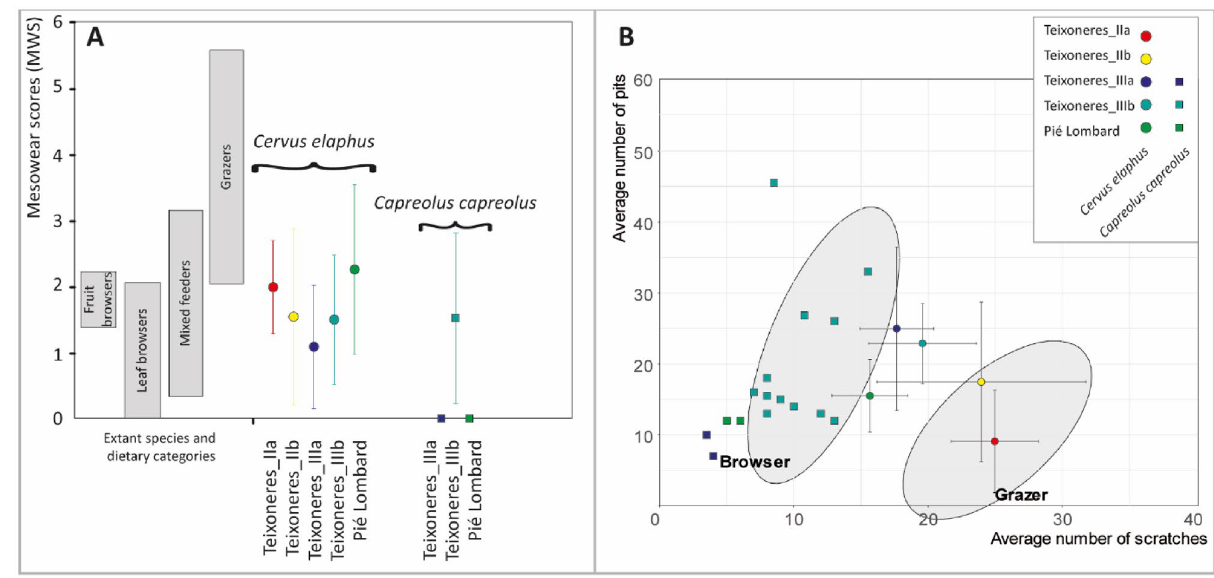
Figure 7. ( A ) Mesowear score (MWS) of Cervus and Capreolus from Pié Lombard and Teixoneres compared to the values of recent ungulates published by Fortelius and Solounias 62 , Solounias and Semprebon 102 , Rivals et al. 121,122 . ( B ) Bivariate plot of the mean number of pits and scratches of Cervus and Capreolus from Pié Lombard and Teixoneres. The error bars correspond to the standard deviation (± 1 SD). The ellipses correspond to the Gaussian confidence ellipse ( p = 0.95) on the centroids of current grazers and browsers published by Solounias and Semprebon 102